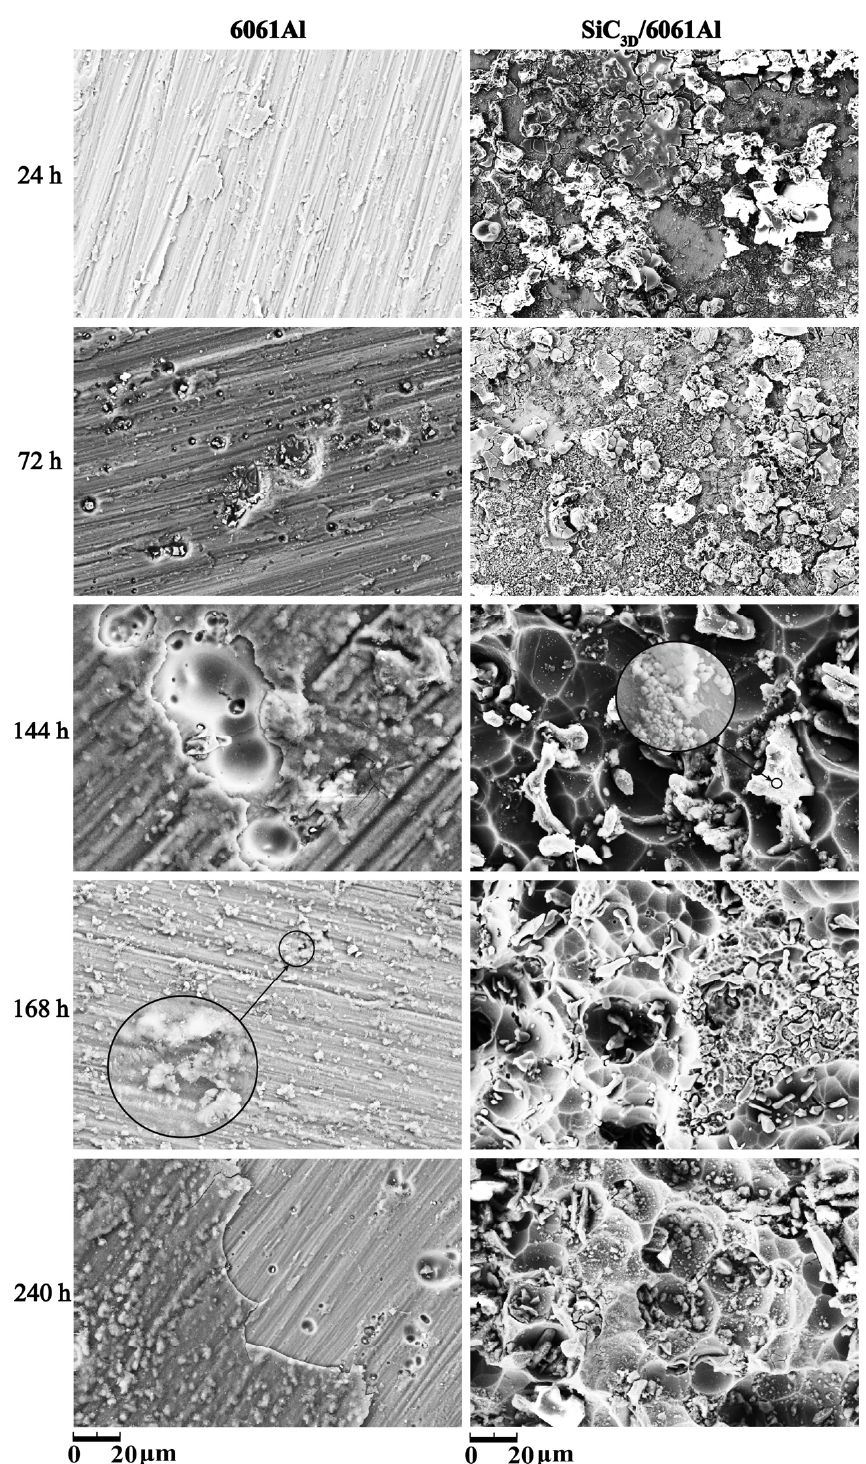
Figure 7. Corrosion product morphology under different times after NSS corrosion.